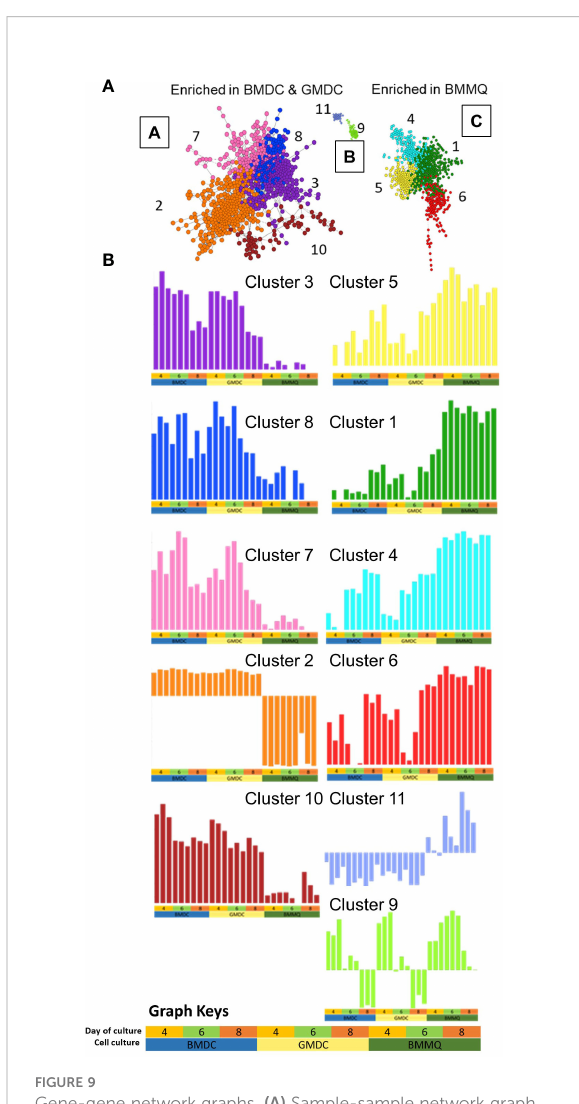
FIGURE 9 Gene-gene network graphs. (A) Sample-sample network graph. The graph is colored based on experimental groups and shows 3 clusters (A – C) comprised of 11 separate clusters (1-11). Each sphere (node) represents a gene, and lines between them (edges) show Pearson correlations between them of ≥ 0.95. Primary separation of samples is based on culture type. (B) Gene-gene network graphs demonstrating the expression pattern of the genes within the 11 clusters (1-11). The culture type and day of culture are denoted by the key at the base of the fi gure and used under each